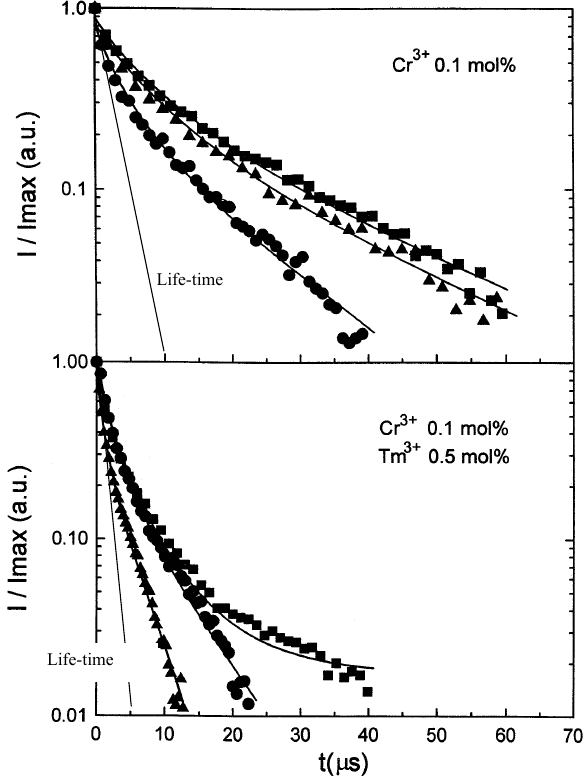
Figure 10. NbOHC band recovery after gamma irradiation, reprinted with permission from [20]. Copyright 1996 Elsevier.